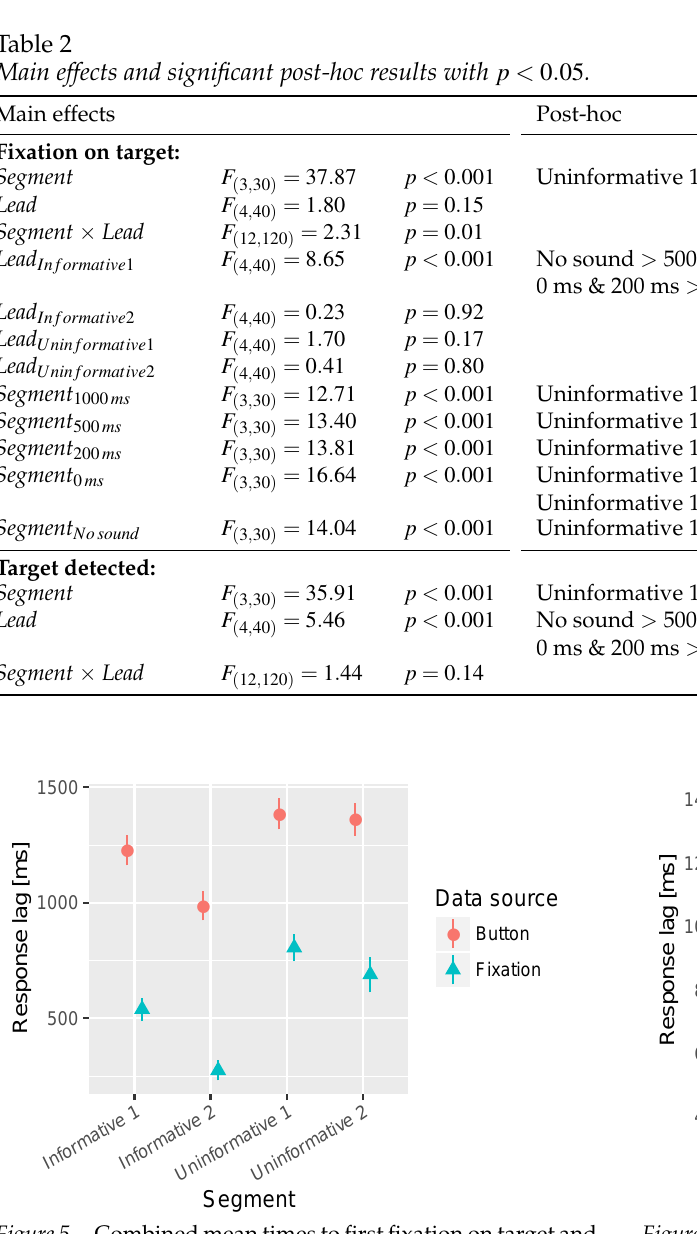
Figure 5 . Combined mean times to first fixation on target and button press for the segments containing informative sounds and uninformative sounds. All audio lead times are col- lapsed together in this analysis. The bars represent the 95 % confidence intervals of the mean.